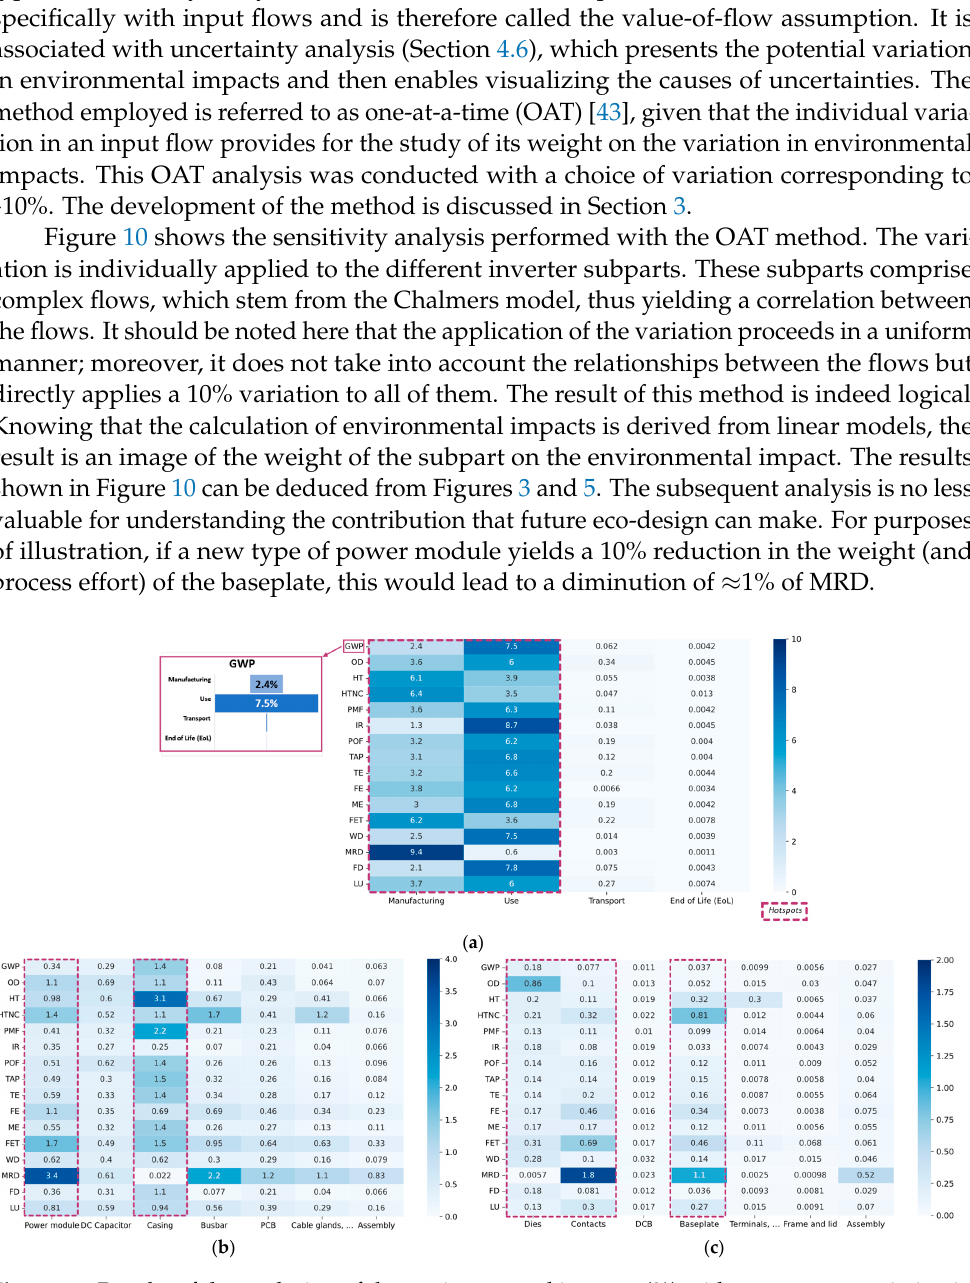
Figure 10. Results of the evolution of the environmental impacts (%) with respect to a variation in the input of 10% (OAT method). The life cycle analysis of the various subparts of an inverter operating point for a 150 kW load from a DC power source of 450 V, based on 15 years and 10,000 operating hours. ( a ) Inverter life cycle; ( b ) Inverter manufacturing; ( c ) Power module. Abbre- viations are presented in Table